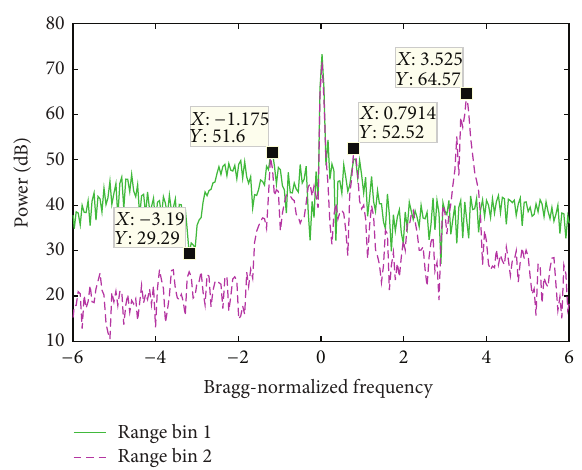
Figure 9: Echo power spectrum density of two range bins.